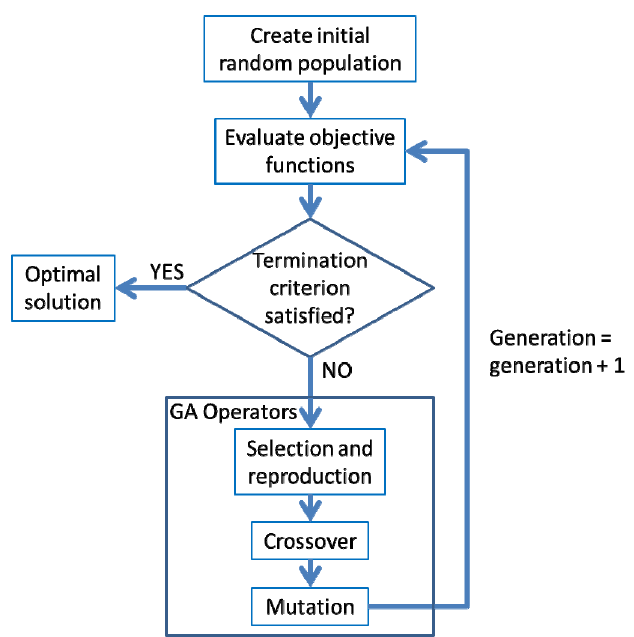
Figure 2. Overview of the GA